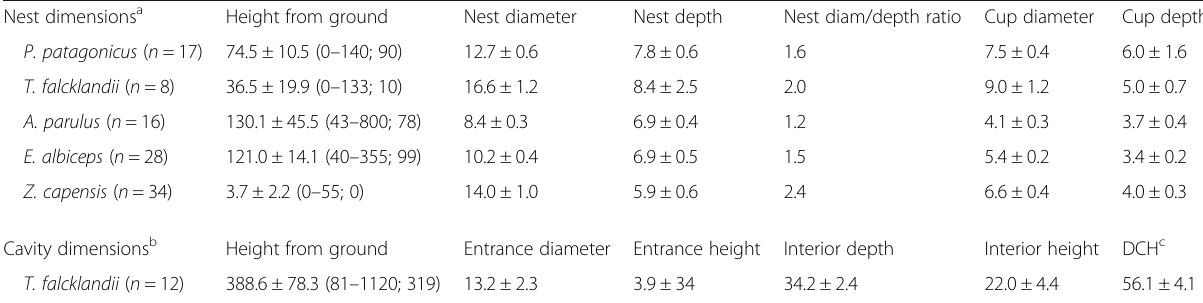
Table 1 Nest height from ground, and nest and cavity dimensions (cm) of five forest-nesting bird species Nest dimensions